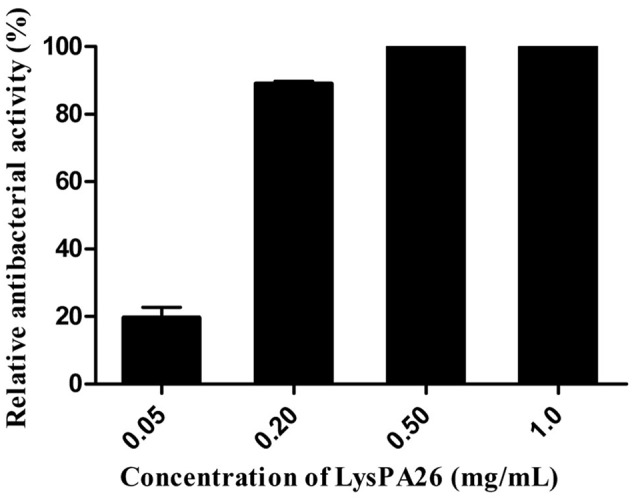
Antimicrobial activity assay of LysPA26. Different concentrations of LysPA26 (0.05, 0.2, 0.5, 1 mg/ml) were added to washed Pseudomonas aeruginosa D204 cells resuspended in incubation buffer (20 mM Tris-HCl, pH 8.0). The residual cell CFU number of P. aeruginosa treated by LysPA26 was counted and presented as the relative inactivation. Error bars represent the standard deviations of three independent assays.